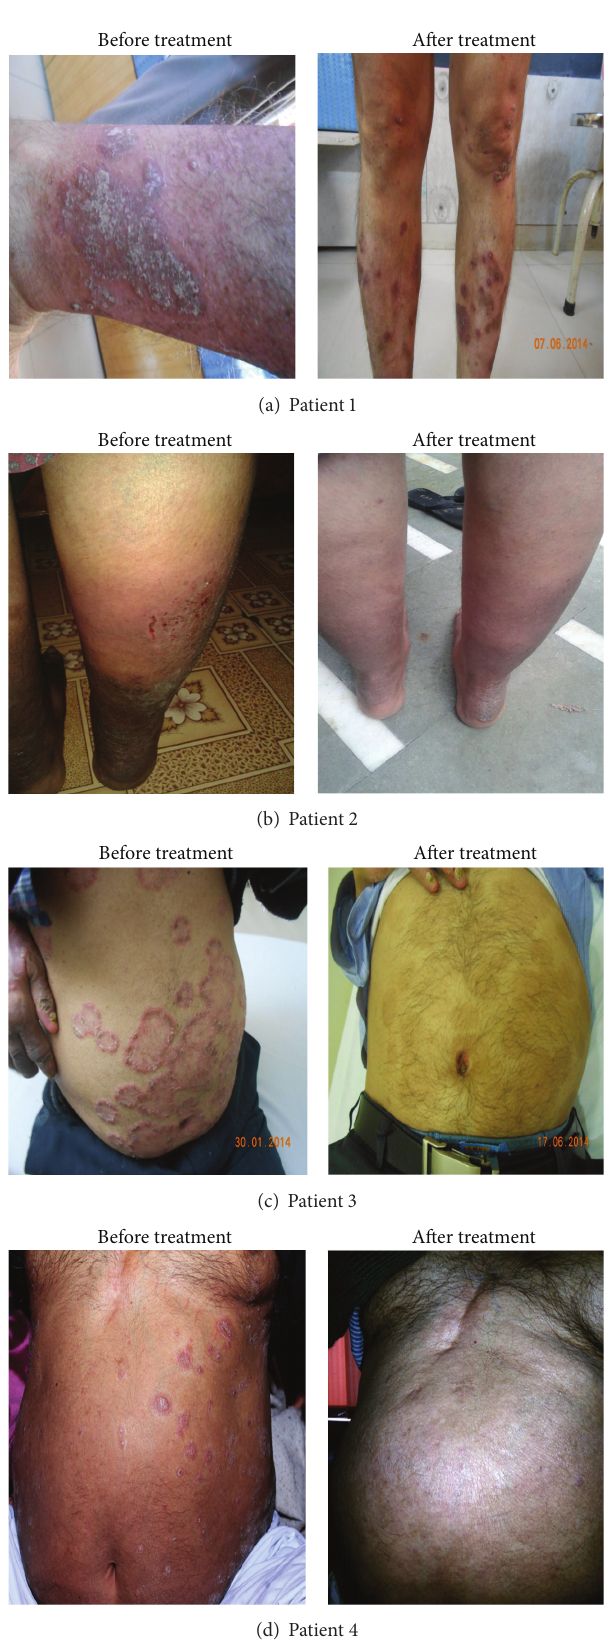
Figure 3: Effect of Itolizumab on psoriasis patients after